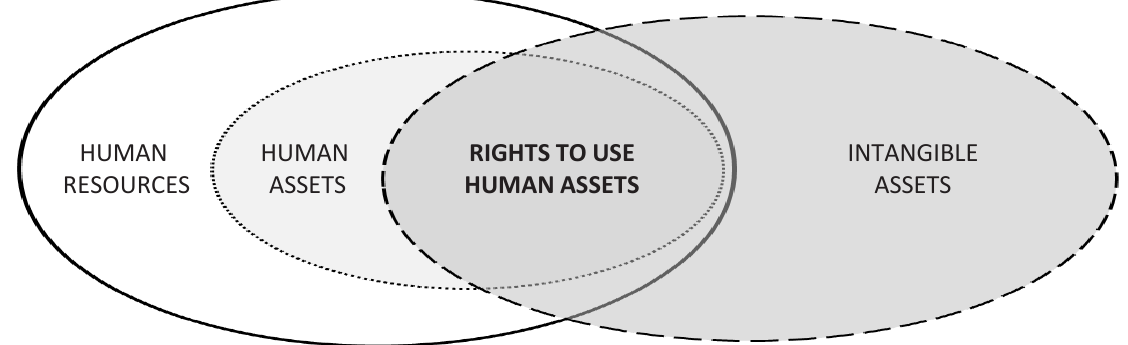
Figure 2. The correlation of concepts: “human resources”, “human assets”, “rights to the use human assets” and “intangible